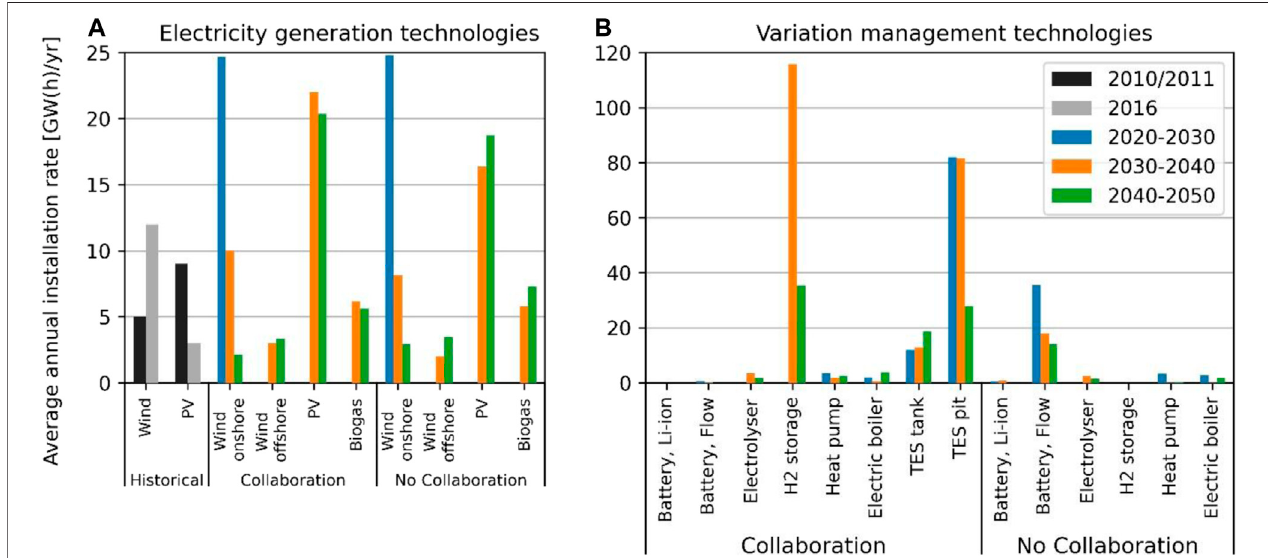
FIGURE 5 | Average annual installation rates for: (A) electricity generation capacity (GW/yr); and (B) variation management technology capacity (GW(h)/yr). The graphsshowstheaverageannualcapacityadditionsintheperiod2020 – 2050fortheentireregionmodelledintheCollaborationscenarioandNoCollaborationscenario,